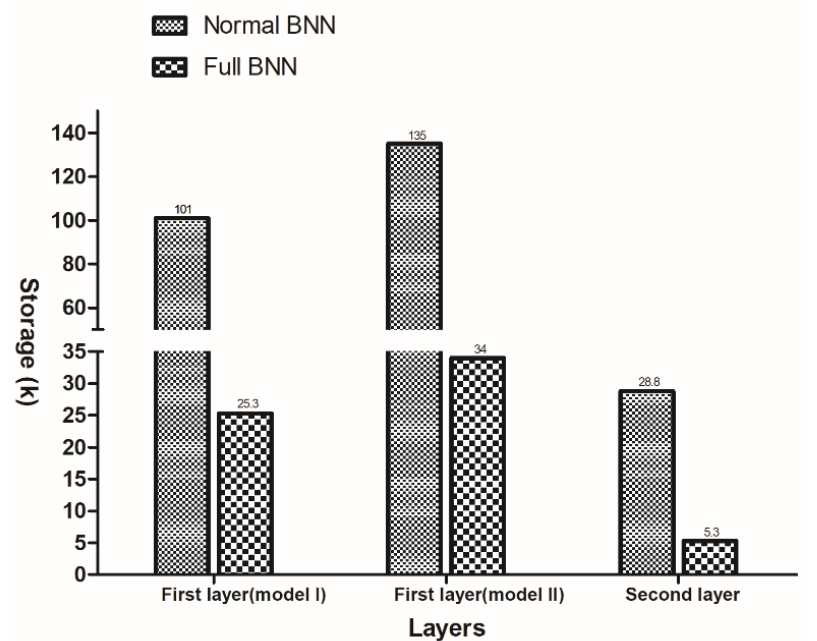
Figure 14. The impact of the codesign technology of convolution and batch normalization on storage requirements.